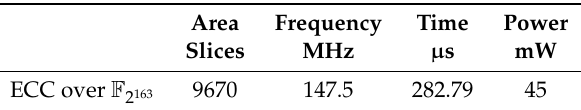
Table 2. ECC Performances over F 2 163 .